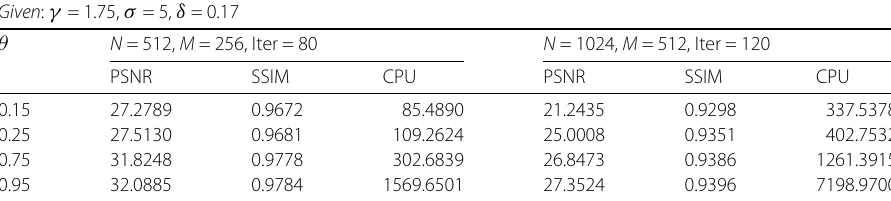
Table 9 Computational results for each θ